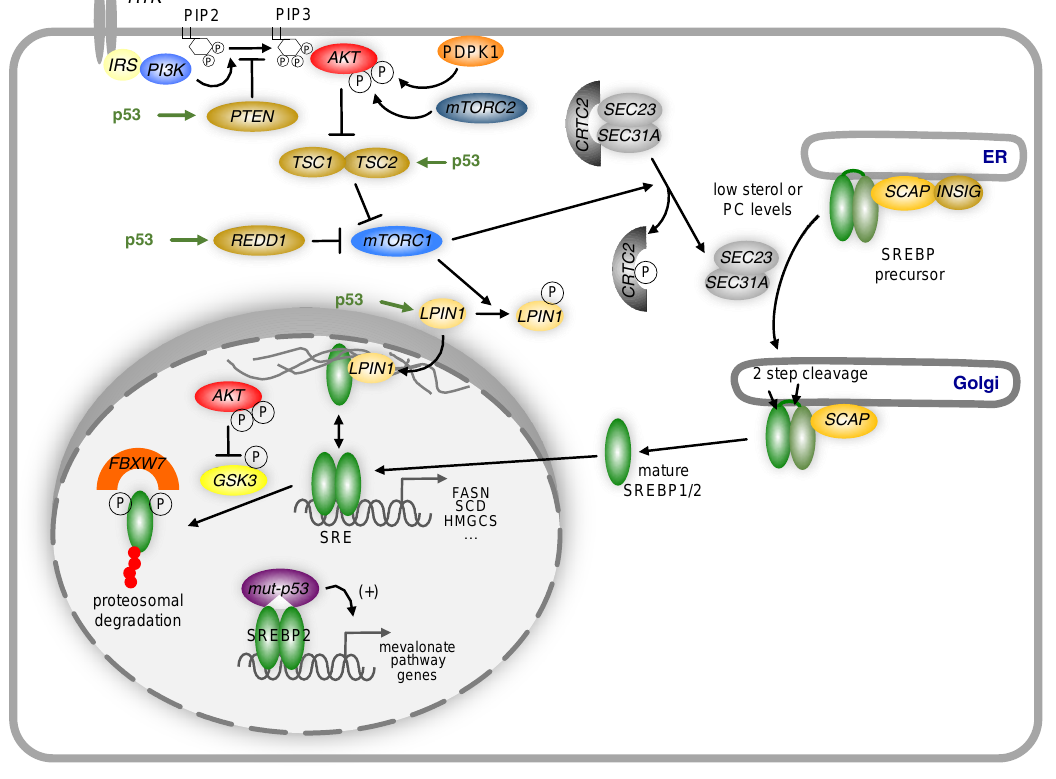
Figure 3. Regulation of SREBP by p53.